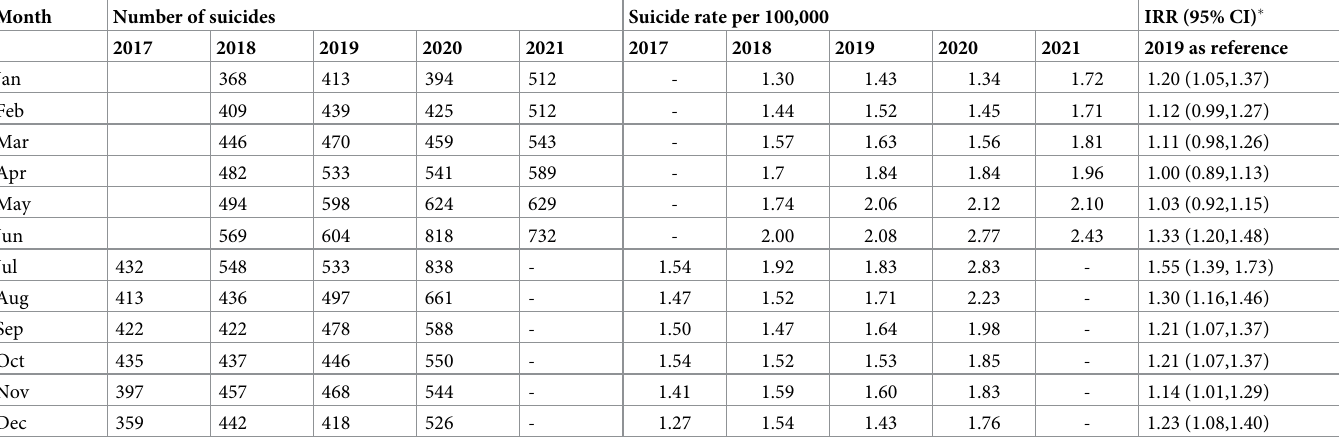
Table 2. Monthly suicide counts, rates, and incidence rate ratio (IRR) in Nepal from 2018 to